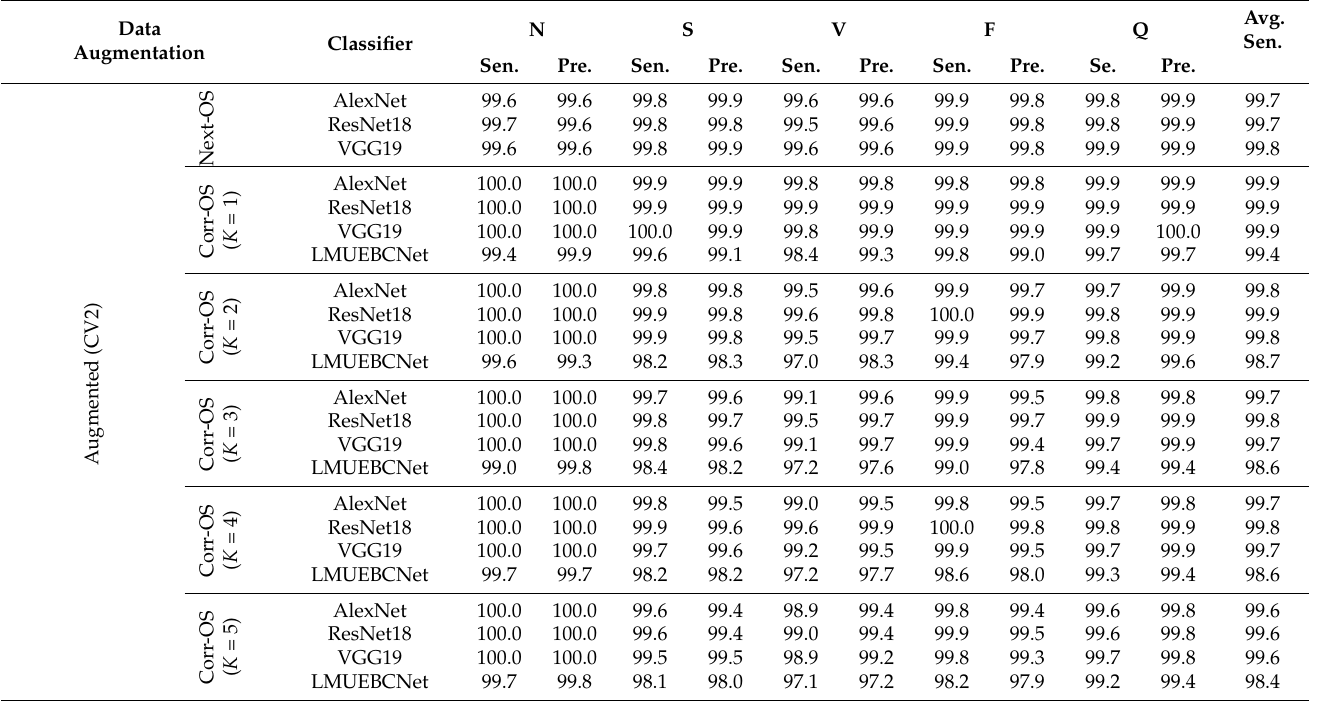
Table A2. Sensitivity/precision of LMUEBCNet with existing models using native/Corr-OS/Next-OS dataset under CV2.